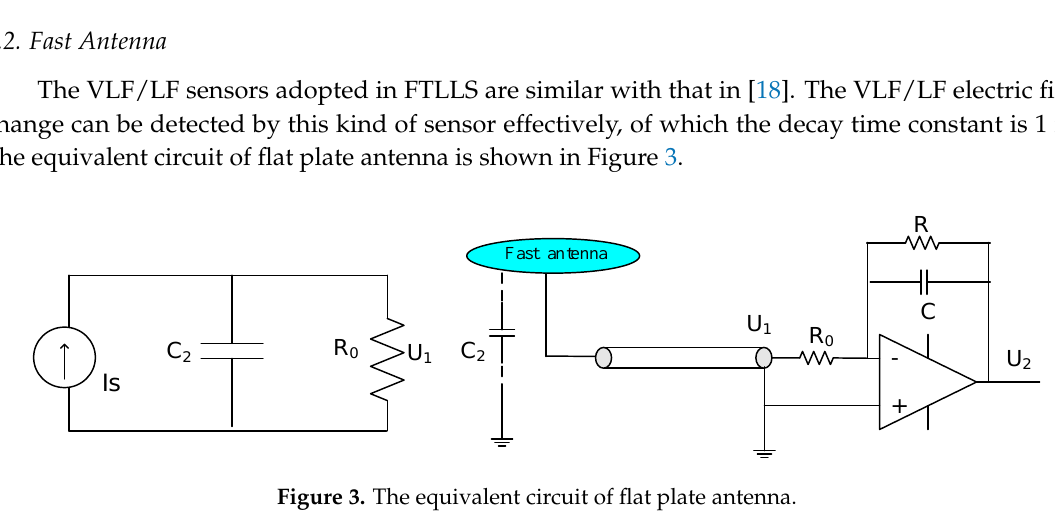
Figure 3. The equivalent circuit of flat plate antenna.